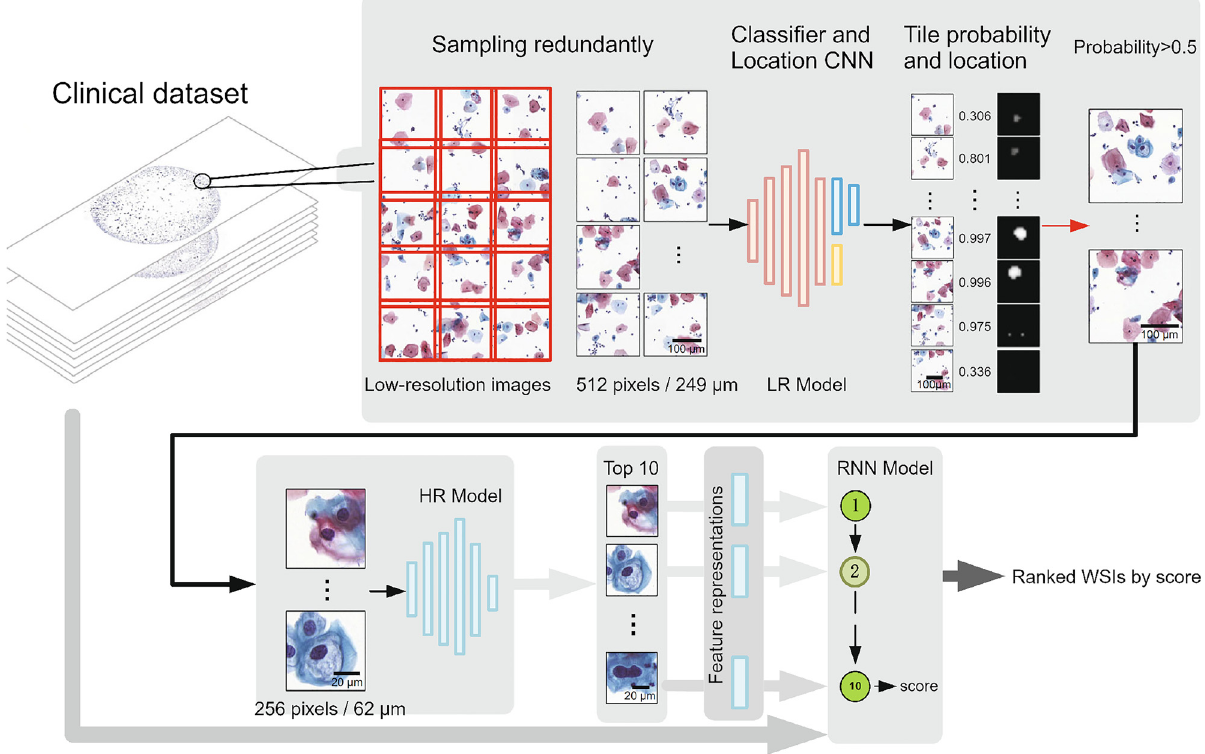
Figure 4: Image analysis for a coarse-grained classification of histopathology slides using a CNN . A low-resolution image of the entire slide is divided into non-overlapping tiles, which are independently passed through a low-resolution model that locates suspicious lesion regions. These regions are identified at high resolution by the high-resolution model that outputs a probability of the presence of a lesion cell in a tile. This high-resolution model outputs the ten most suspicious lesion tiles. Finally, these ten highest-scoring tiles are analyzed by an RNN to produce a final score for the entire slide. Image reproduced with permission from Ref.